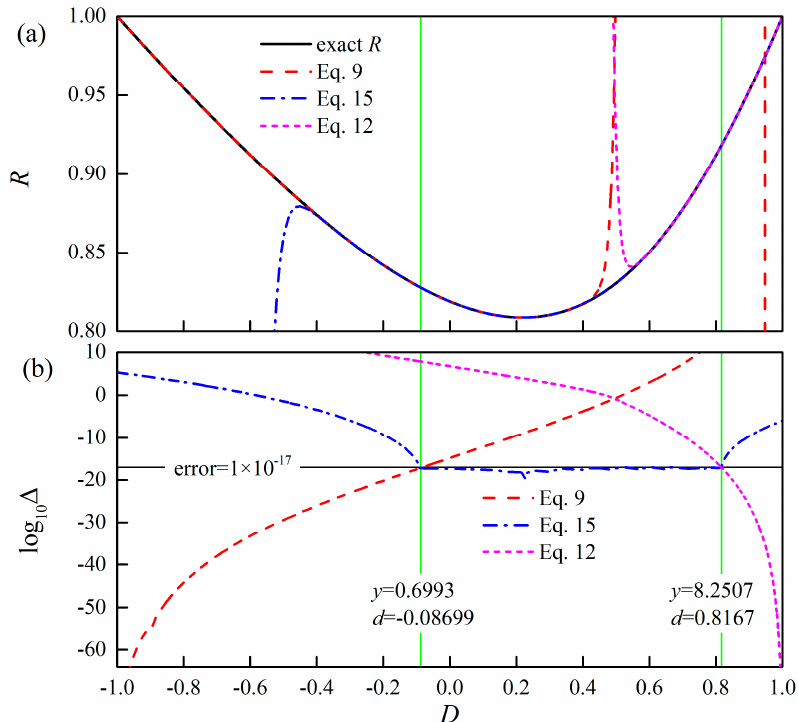
Figure 1. ( a ) The comparison of each half-width function and ( b ) the logarithm of relative error for the half width of the Voigt profile, respectively, in the R , D format.